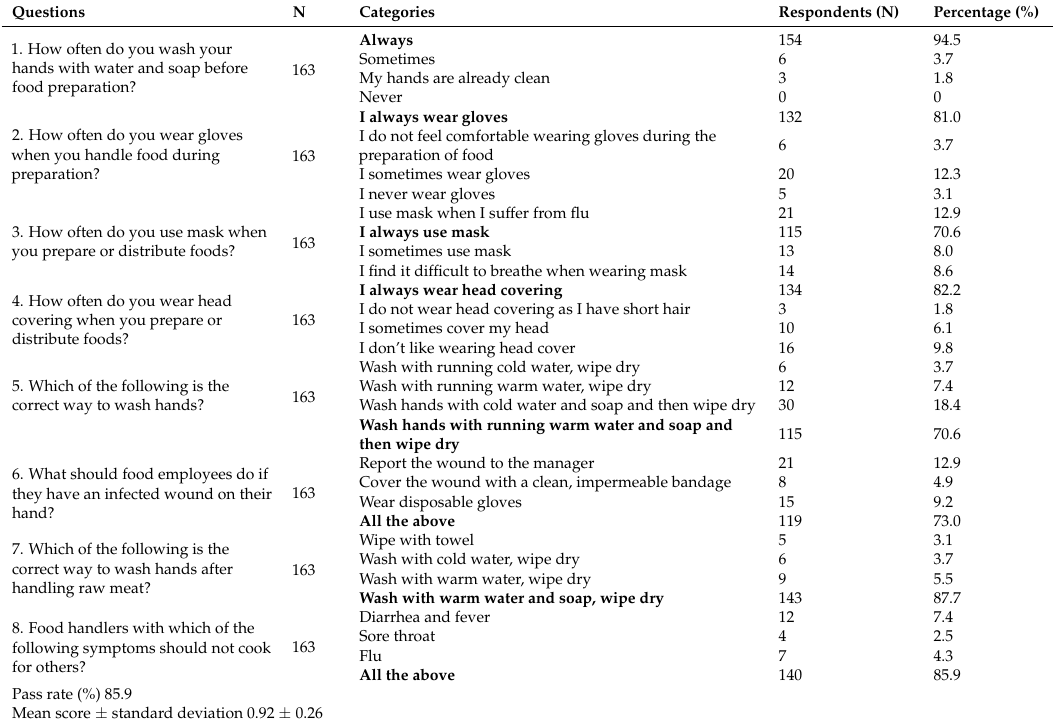
Table 6. Food handlers answers for practices